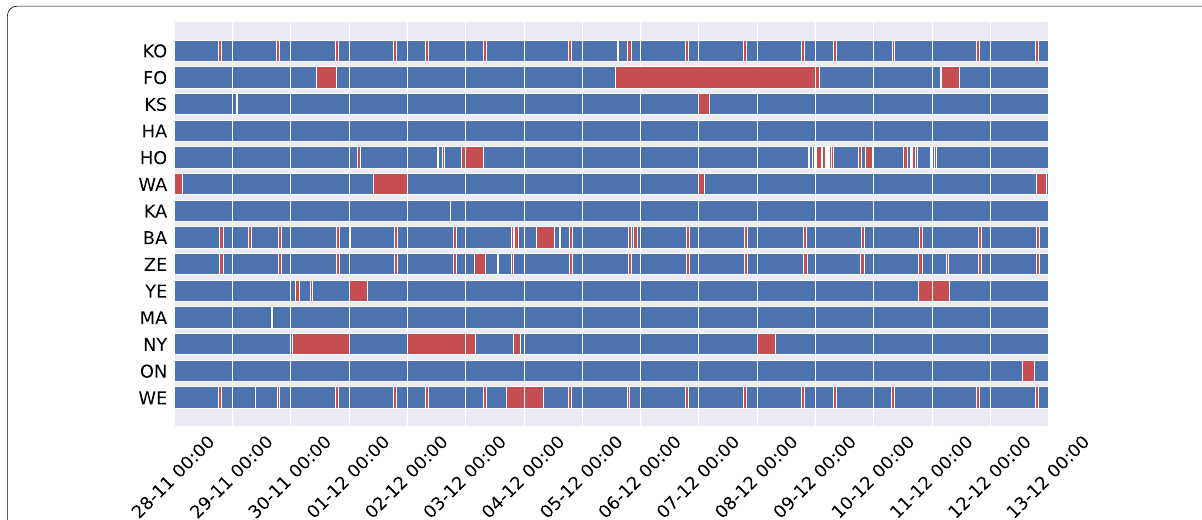
Fig. 2 An overview of the observation schedule for the Legacy‑1 network during the CONT17 campaign. The data‑gaps are presented in red and were taken from International VLBI Service (2017)